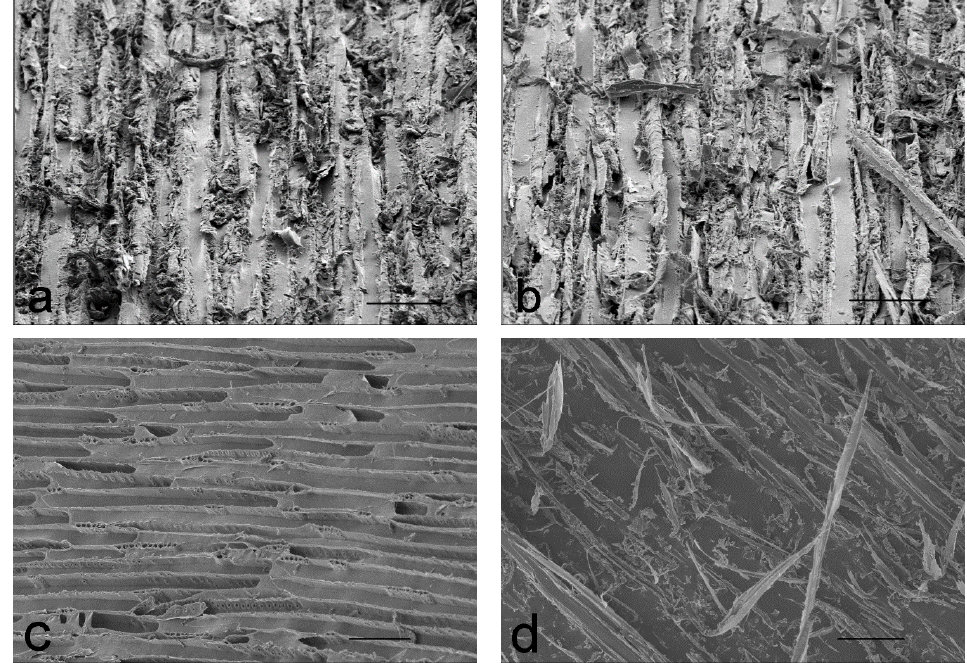
Figure 5. Western red cedar wood surfaces after: ( a ) sanding; ( b ) sanding and wetting/redrying; ( c ) planning/wetting/redrying; and ( d ) material removed from (b) using transparent tape. Scale bars = 100 μ m.